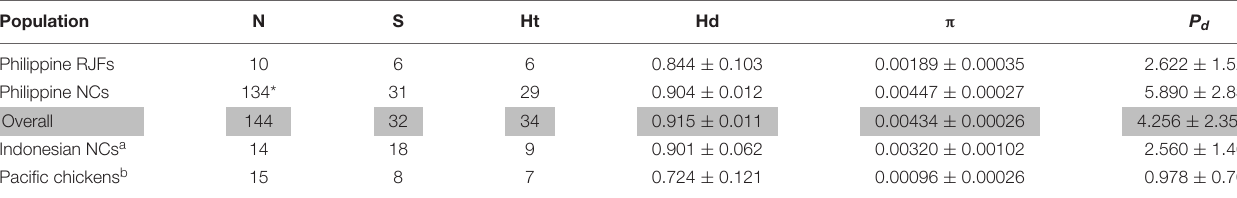
TABLE 1 | Genetic diversity indices of red junglefowl (RJF) and native chicken (NC) populations [complete mitochondrial DNA (mtDNA) D-loop sequence] and their haplogroup distributions. Population